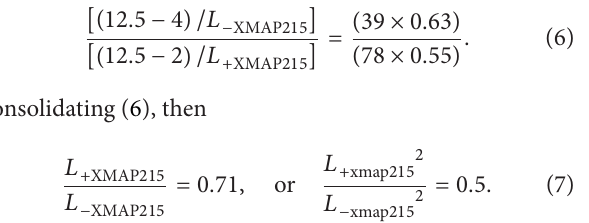
Figure 1: The durations of fast and slow growth periods of microtubule assembly and the length of microtubule growth in a fast growth period. The duration measurements were conducted with data in [10, 11], while the length measurements were only conducted with data in [11] since information on such lengths is available in